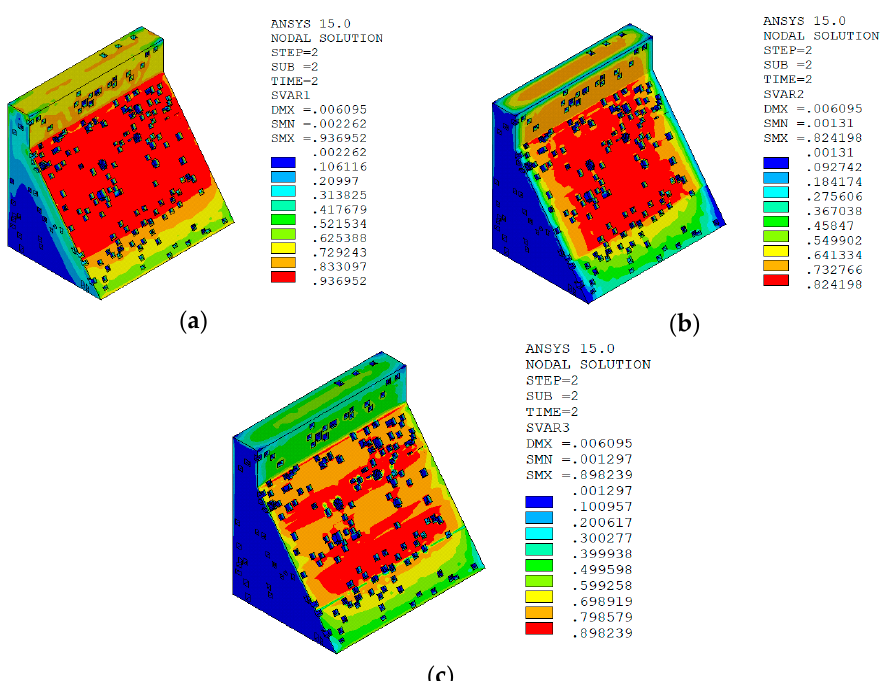
Figure 15. The temperature damage distribution of the mortar material in the three principal strain directions is calculated by the macro-meso model under the temperature drop condition, ( a ) The temperature damage distribution in the first principal strain direction, ( b ) The temperature damage distribution in the second principal strain direction, ( c ) The temperature damage distribution in the third principal strain direction.